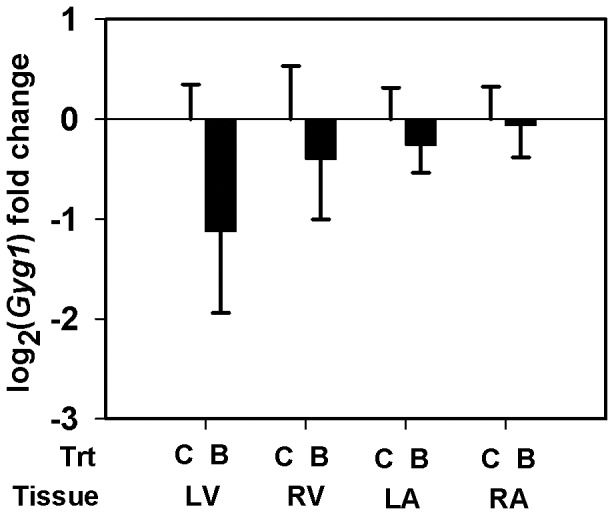
Real-time PCR quantification of glycogenin (Gyg1) expression.Expression of Gyg1 mRNA in the left ventricle (LV), right ventricle (RV), left atrium (LA) and the right atrium (RA) of rhesus monkey (Macaca mulatta) fetuses at birth was measured. Fetuses were exposed maternally to a 400 µg/Kg. body weight of BPA dose (B) or 150 µL ethanol (C) during late gestation (LG, days 100±2–term). Data were analyzed by tissue and bars represent the mean ± S.E.M. of the log2 (fold change). A two sample t-test was performed to identify significant BPA effects and a two-tailed p≤0.05 was considered statistically significant.